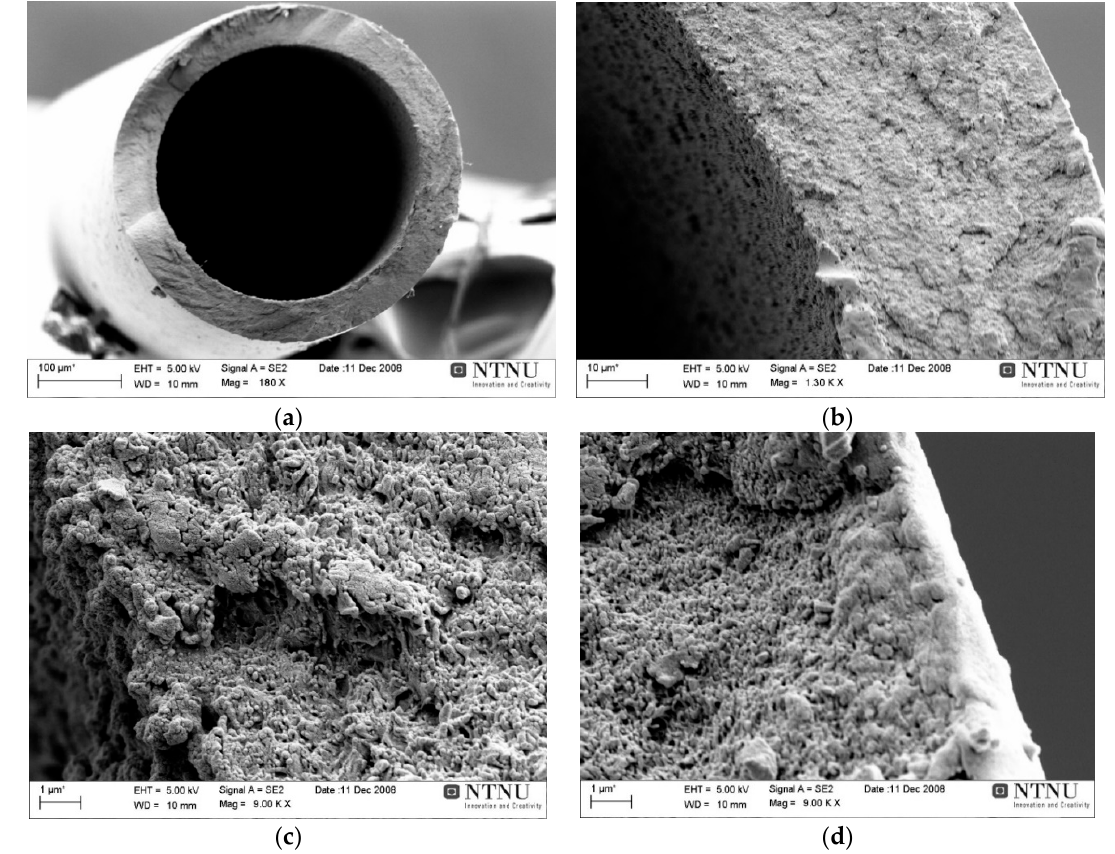
Figure 10. ( a ) Regenerated CHF after deacetylation of CAHF/cross section ( b ) wall magnified ( c ) wall inner edge magnified ( d ) wall outer edge magnified.